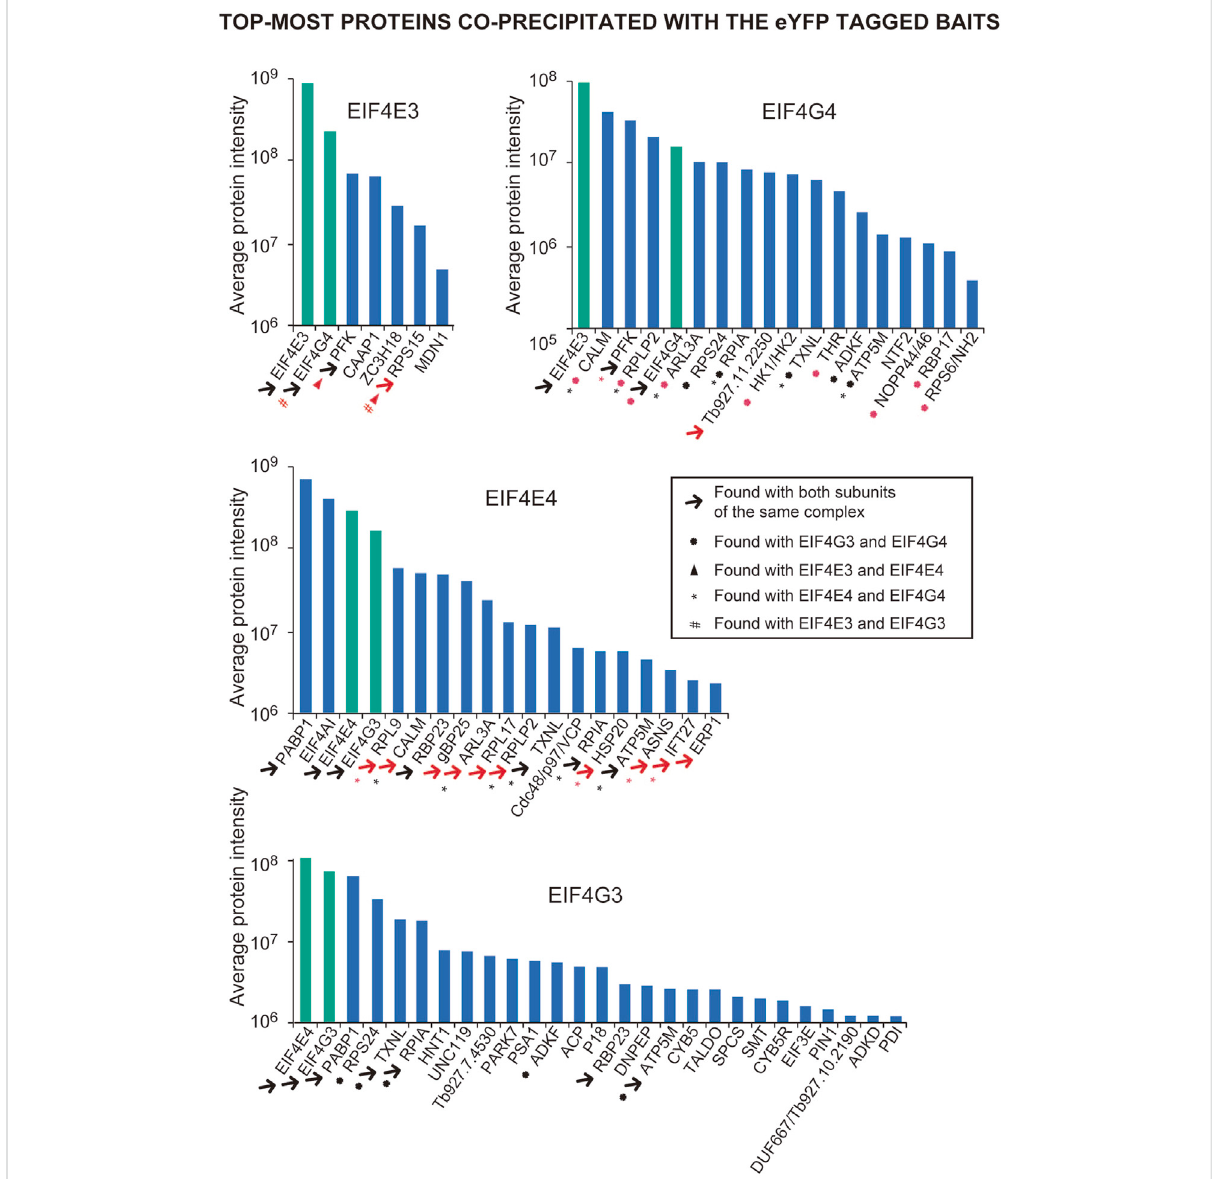
FIGURE 2 Overview of the top-most proteins co-precipitated with the eYFP tagged EIF4E3, EIF4E4, EIF4G3 and EIF4G4 in Trypanosoma brucei procyclic cells. Bar charts highlighting the proteins listed in Tables 1 – 4 and with enrichments relative to the negative control > 4-fold (for EIF4E3, EIF4E4 and EIF4G4) or > 8-fold and with intensities greater than 10 6 (for EIF4G3). The four proteins directly investigated here are highlighted by the green bars. Thedifferentsymbolsareindicatedwithinthebox,withsymbolscoloredinblackgenerallyindicatingthattheproteinsco-precipitatingwiththe corresponding pair are among those shown in Tables 1 – 4, while the red color indicates those that are also present with the protein pair with a lower enrichment( < 4and > 1.5;shownintheSupplementaryTablesS2 – S5).Thedifferencesinintensitiesseenforthefourbaitsmay,tosomeextent,re fl ect differences in abundance between